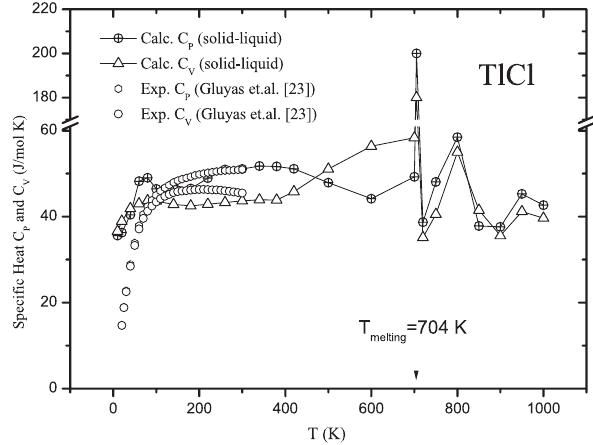
Fig. 5: Variation of specific heat constant pressure and constant volume with temperature for TlCl.